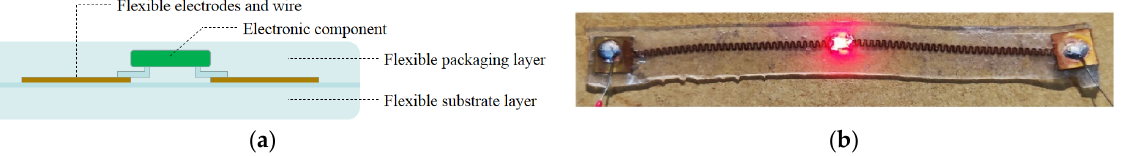
Figure 9. Packaging for stretchable circuits. ( a ) Schematic diagram of single circuit packaging; ( b ) single LED package.